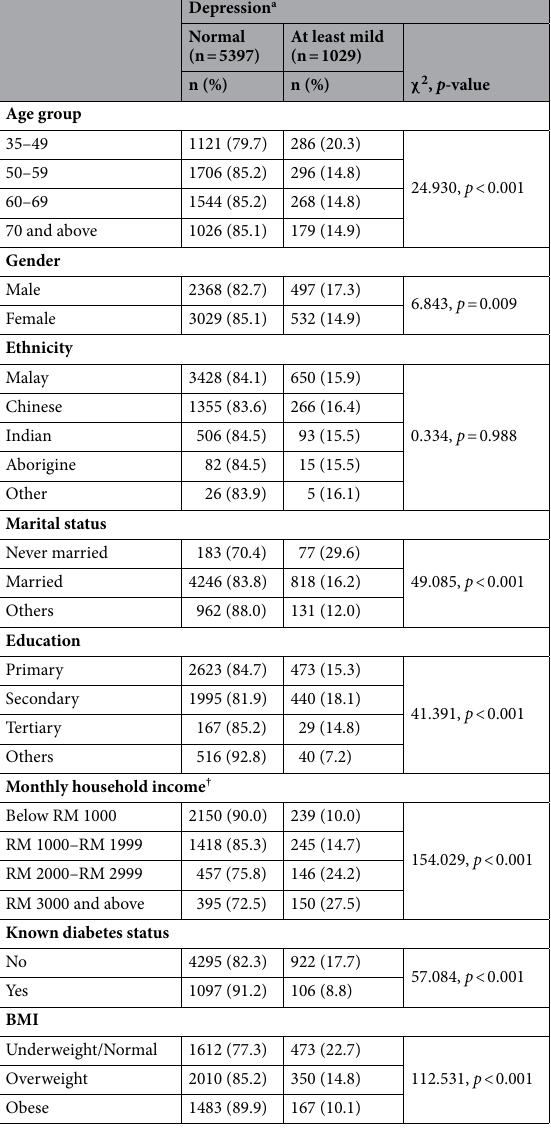
Table 2. Socio-demographics and diabetes status by depression. BMI, Body Mass Index. Values in parentheses are the percentage of the cases. † USD1 is equivalent to RM 3.00 (13th May 2013). a The total number of respondents answered the assessment of depression was